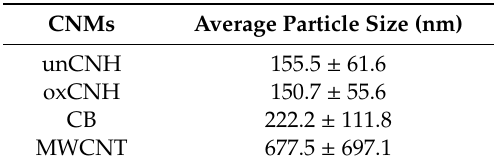
Table 1. The hydrodynamic size of CNMs measured by